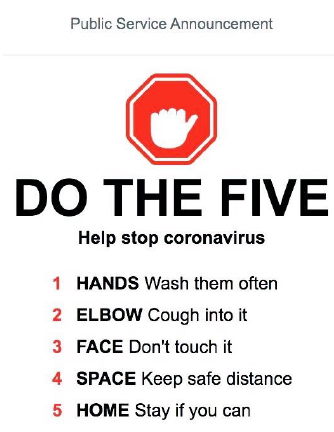
Figure 10. The general five guidelines recommended by the World Health Organization to stop the spread of the